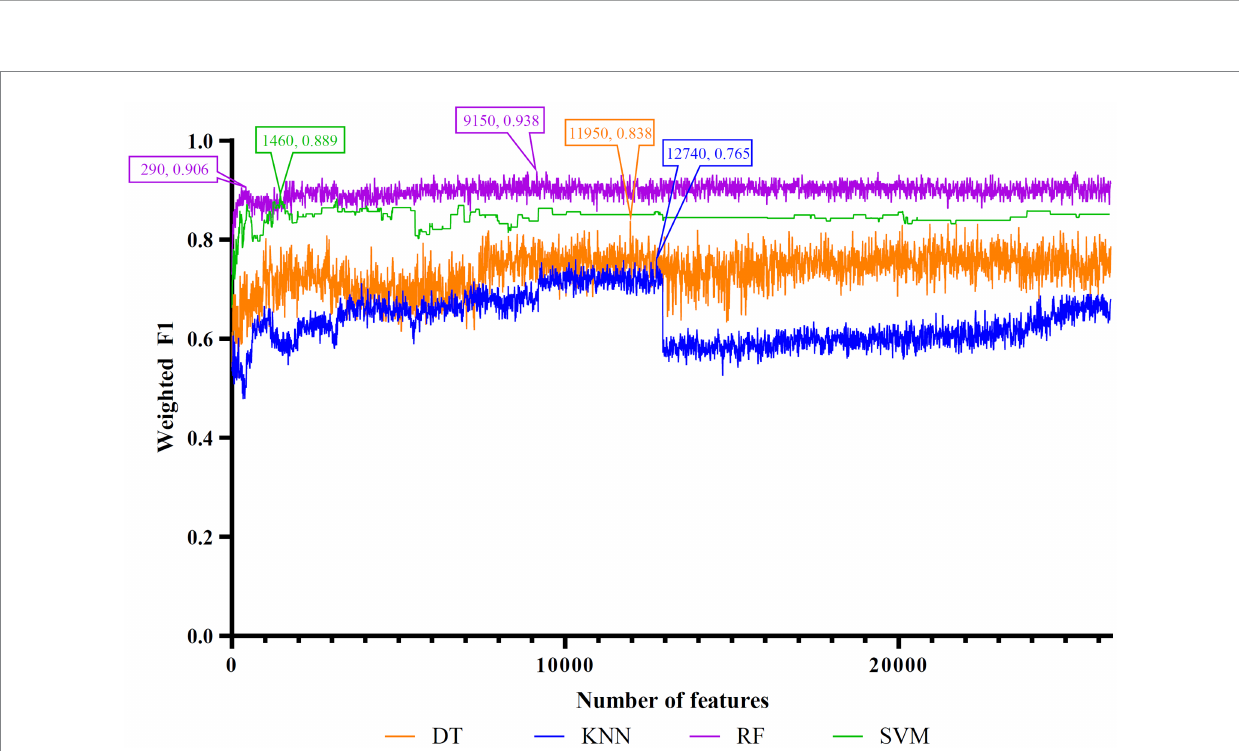
FIGURE 2 IFS curves of four classification algorithms on Lasso feature list. DT, KNN, RF, and SVM yielded the highest weighted F1 values of 0.838, 0.765, 0.938, and 0.889 when top 11,950, 12,740, 9,150, and 1,460 features were adopted, respectively. RF can yield quite high performance (weighted F1 = 0.906) when top 290 features were